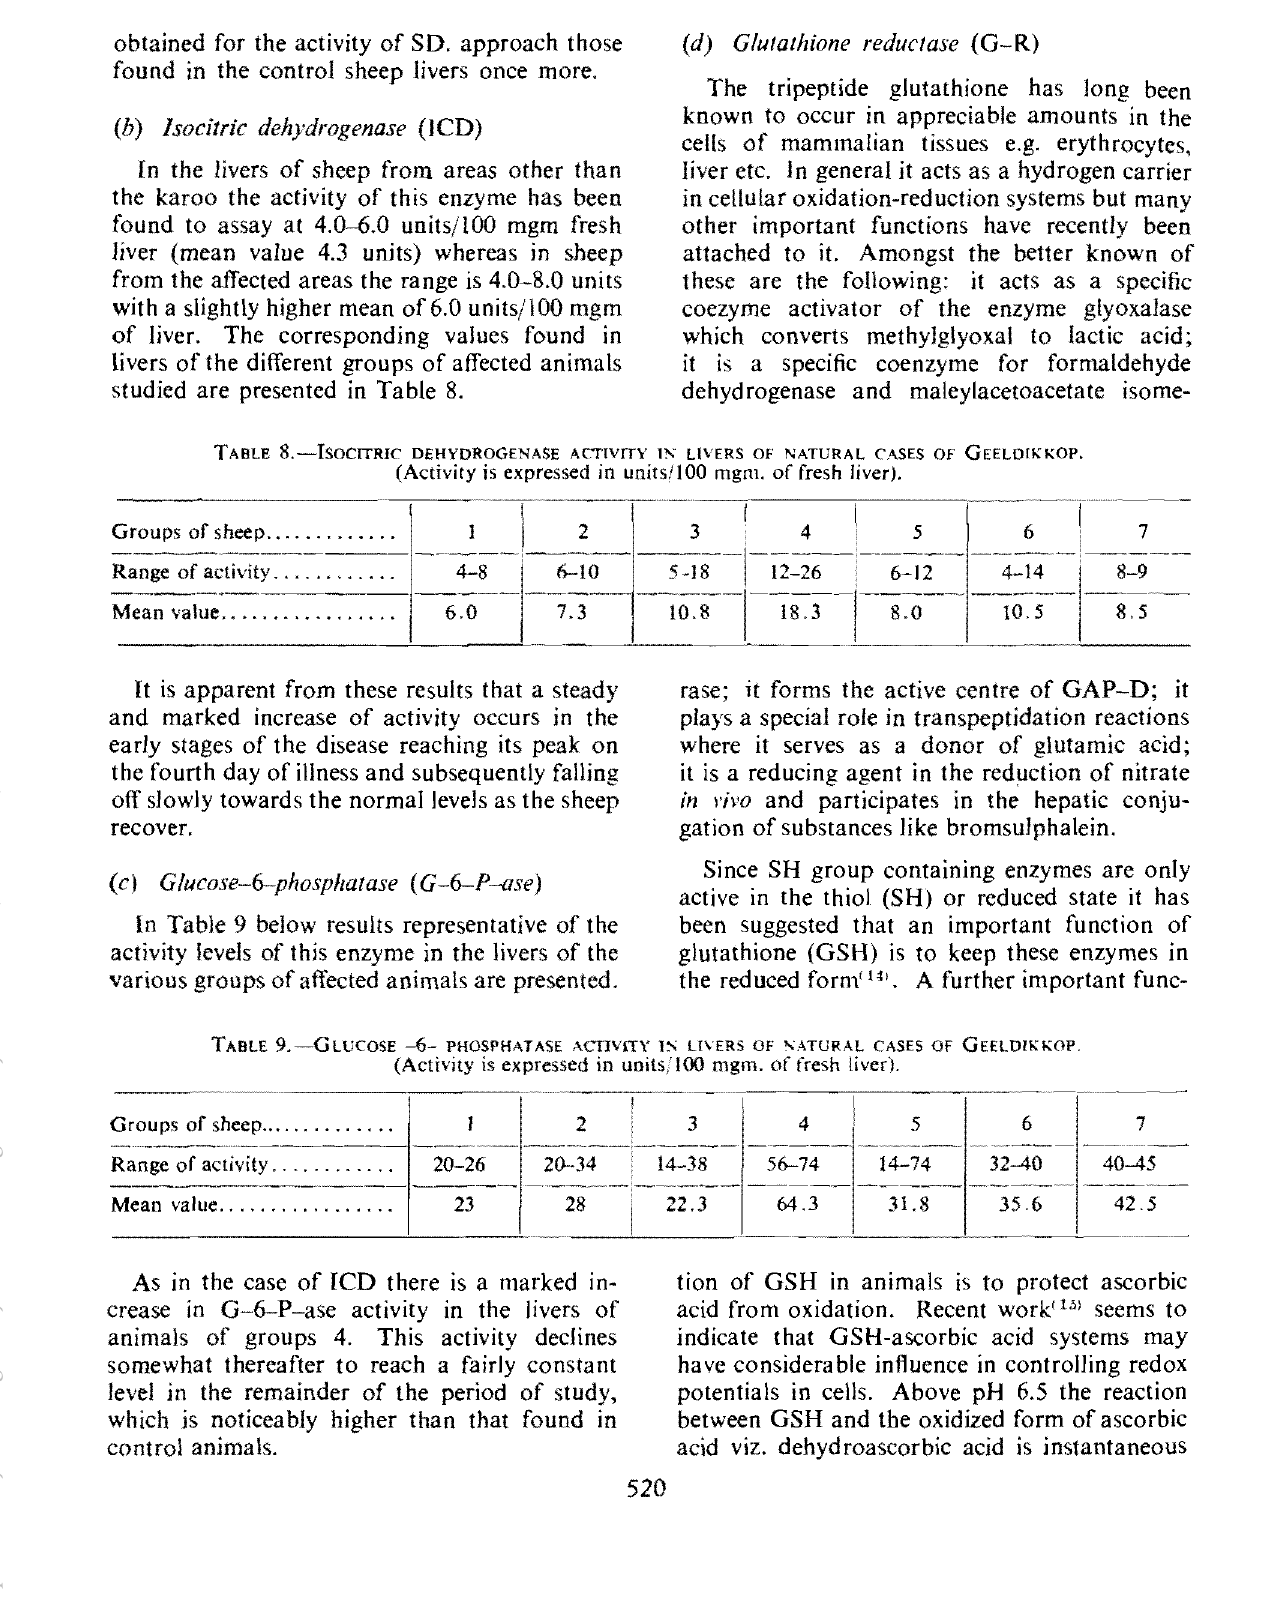
TABLE S.-ISOCITRIC DEHYDROGENASE ActIVITY 11' LIVERS OF NATURAL CASES OF GEELDIKKOP. (Activity is expressed in units/IOO mgm. of fresh liver).